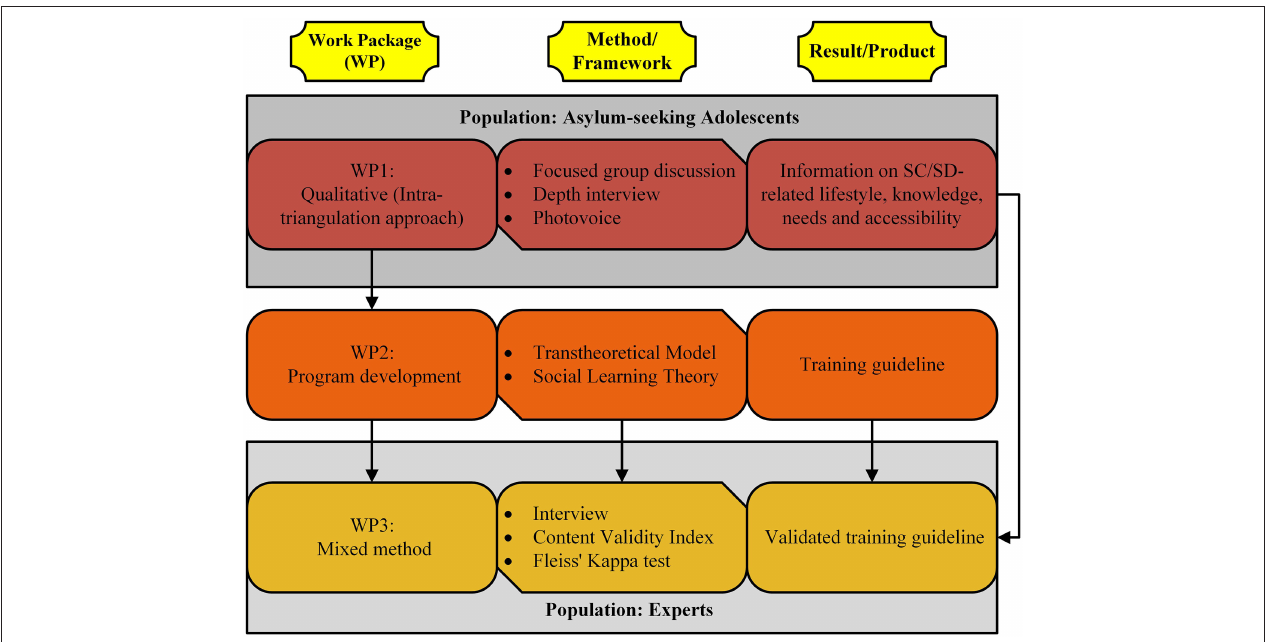
FIGURE 1 | Overview of the SC-SD4ASA study work packages.